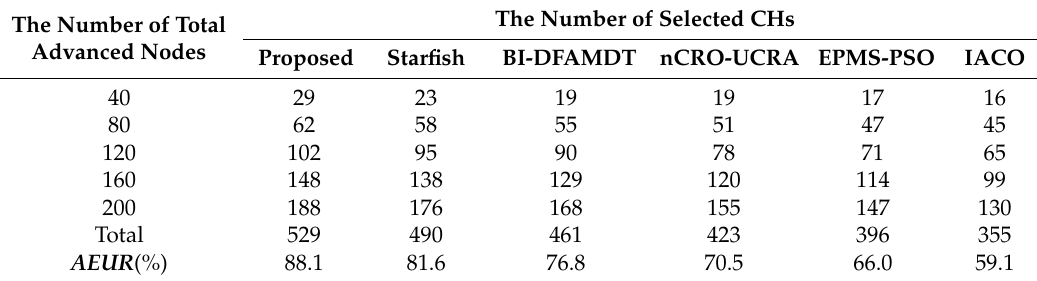
Table 8. Advanced energy usage results for scenario 2.